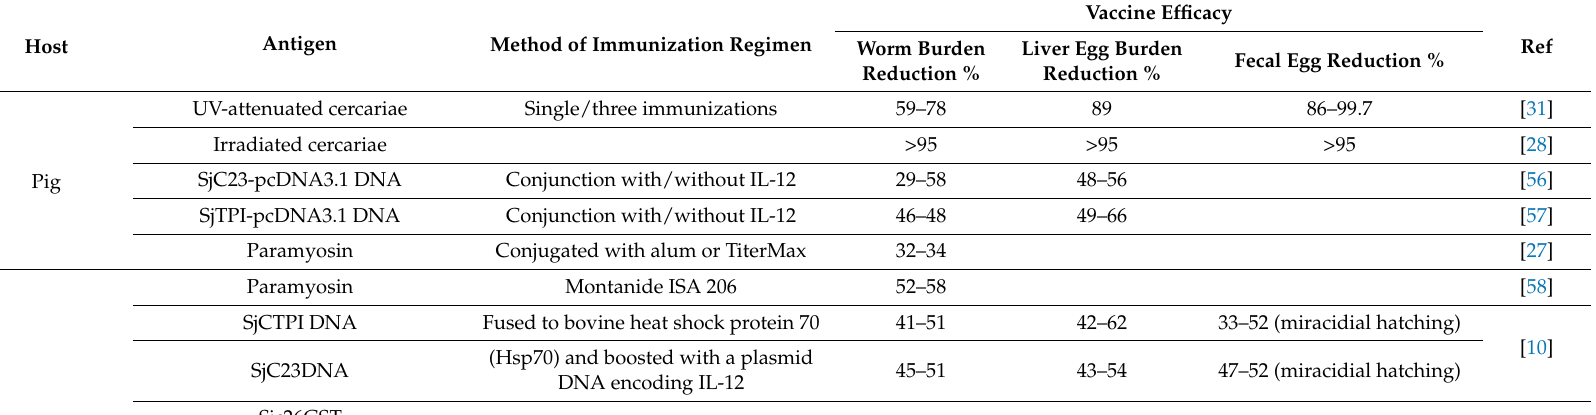
Table 1. S. japonicum vaccines tested in domestic